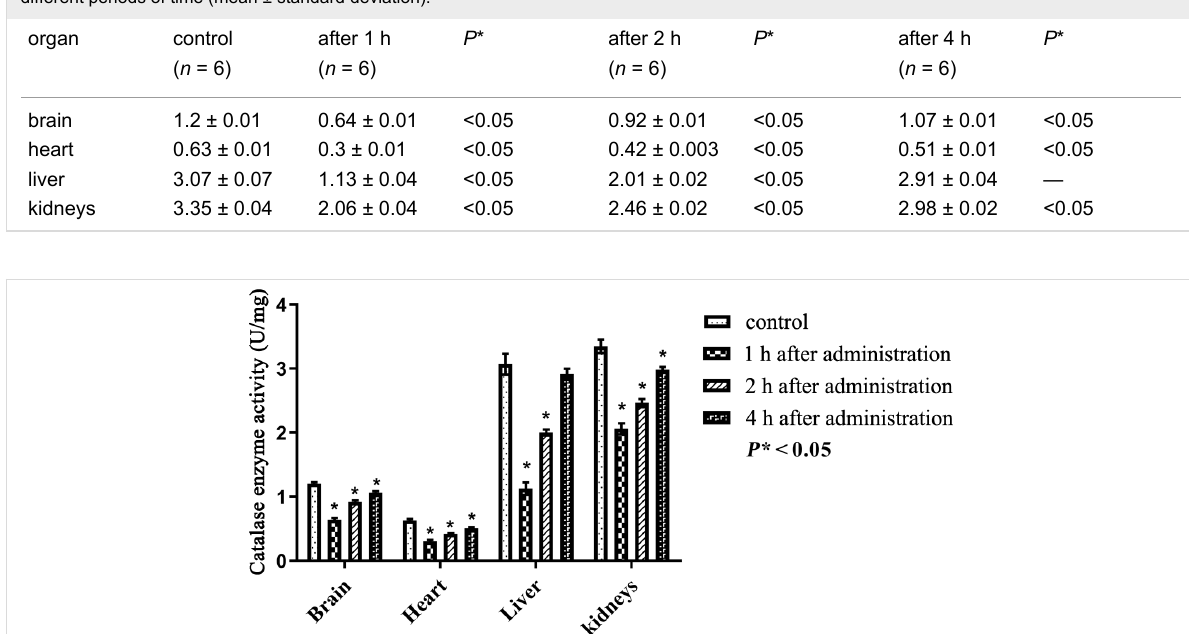
Figure 7: Catalase antioxidant enzyme activity after intraperitoneal administration of PEG-nGO, error bars: one standard deviation.